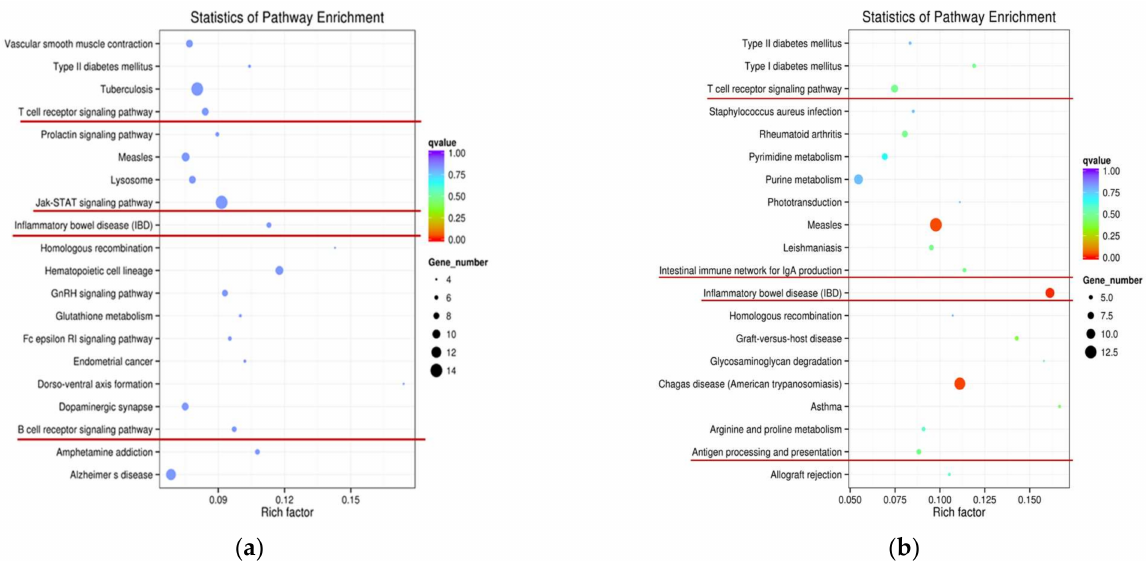
Figure 6. KEGG enrichment analysis of differentially expressed transcripts. axis represented KEGG enriched pathways, and X-axis represented rich factor (rich factor = number of differentially expressed transcripts in this pathway/number of annotated transcripts in background gene set). ( a ) Statistics of pathway enrichment in W4 vs. S4; ( b ) statistics of pathway enrichment in W7 vs.